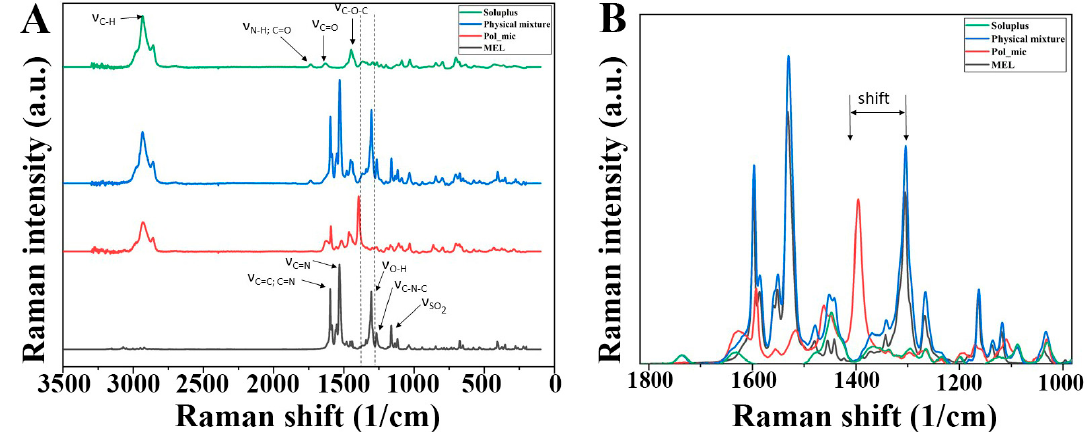
Figure 8. ( A ) Raman spectra of the materials and the ( B ) enlarged region of structural change.